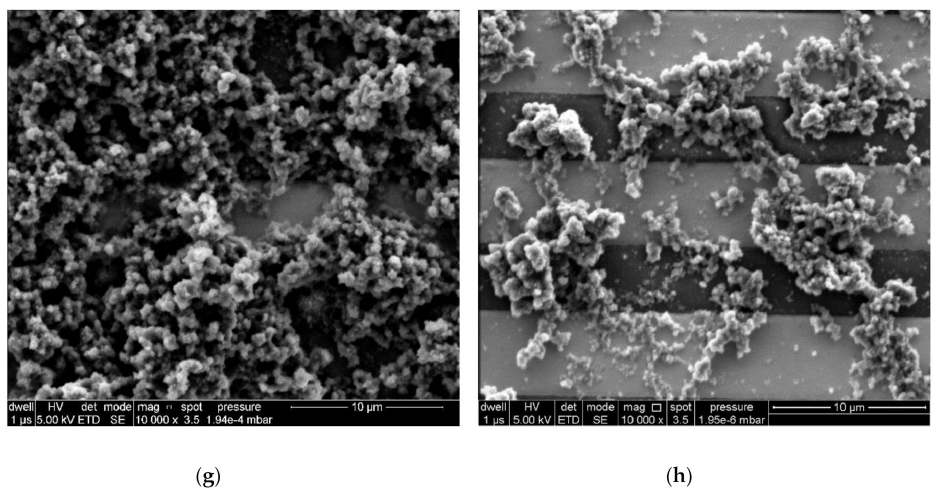
Figure A3. SEM images of PCz electropolymerised on IDE-Pt for: ( a ), ( c ), ( e ), ( g ) ‘Thicker’ film (10 cycles of polymerisation) in different magnifications using Everhart-Thornley Detector ETD (secondary electrons) and low Voltage high Contrast Detector (vCD) (back scattered electrons) detectors ( b ), ( d ), ( f ), ( h ) ‘Thinner’ film (5 cycles of polymerisation in different magnifications using ETD (secondary electrons) and vCD (back scattered electrons) detectors